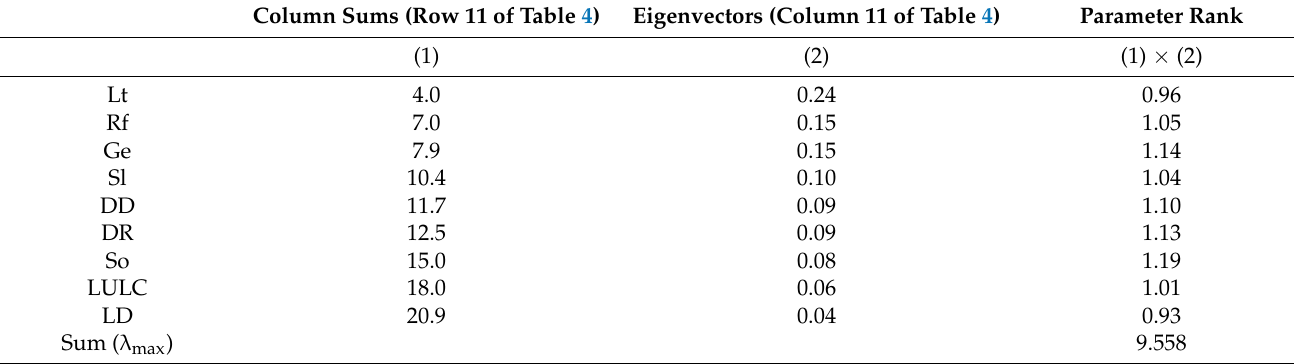
Table 5. Computation of the principal eigenvalue ( λ max